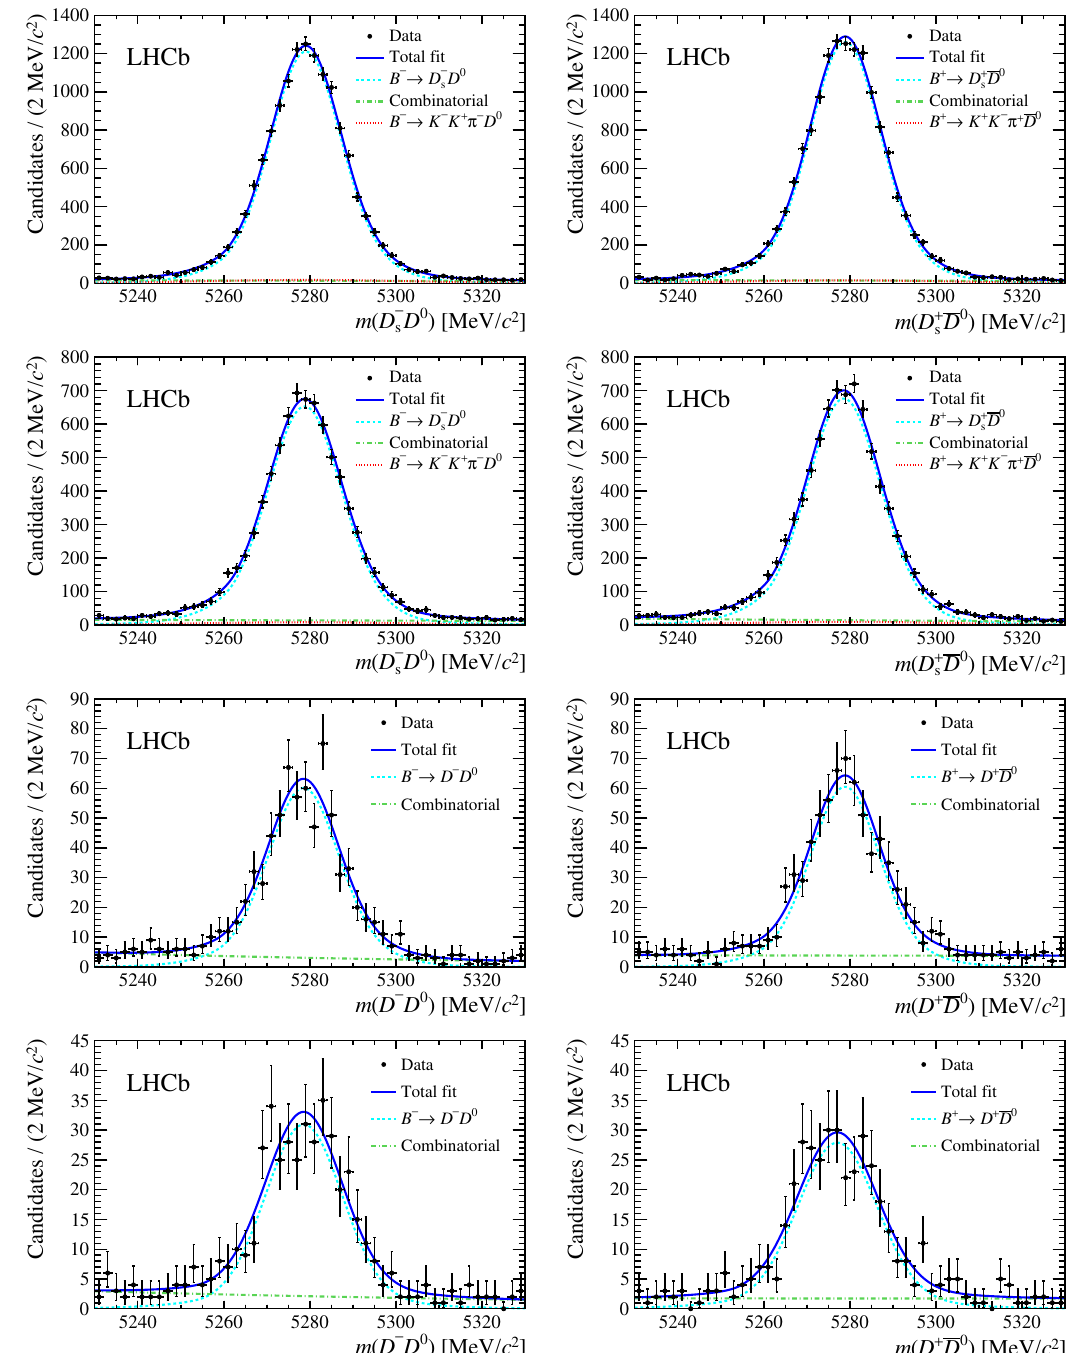
Figure 2 . Invariant-mass distribution of B (cid:0) ! D (cid:0) D 0 candidates, separated by charge. The top ( s ) row plots are B (cid:0) ! D (cid:0) D 0 decays with D 0 ! K (cid:0) (cid:25) + , the second row with D 0 ! K (cid:0) (cid:25) + (cid:25) (cid:0) (cid:25) + . The s plots in the third row correspond to B (cid:0) ! D (cid:0) D 0 candidates with D 0 ! K (cid:0) (cid:25) + , the bottom row with D 0 ! K (cid:0) (cid:25) + (cid:25) (cid:0) (cid:25) + . The left plots are B (cid:0) candidates, the right plots B + candidates. The overlaid curves show the (cid:12)ts described in the